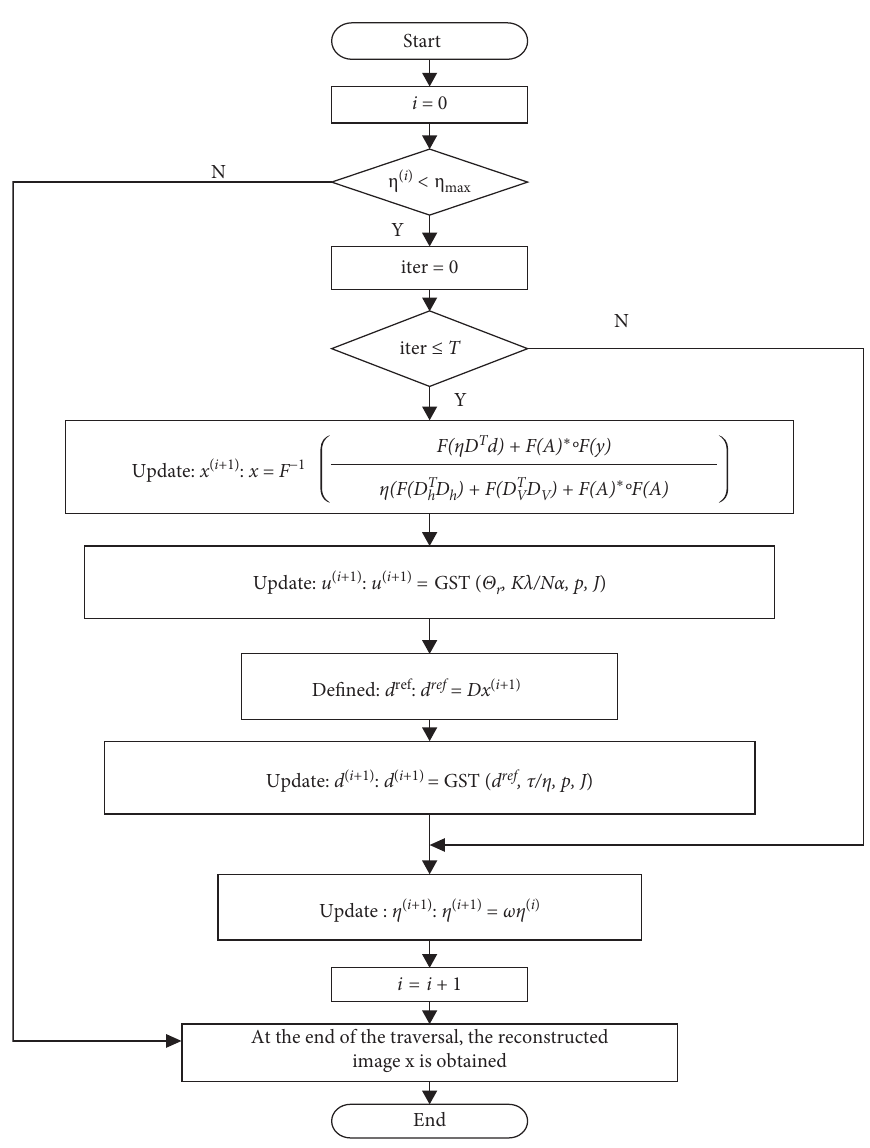
Figure 4: Algorithm flowchart based on GISMT remote-sensing image